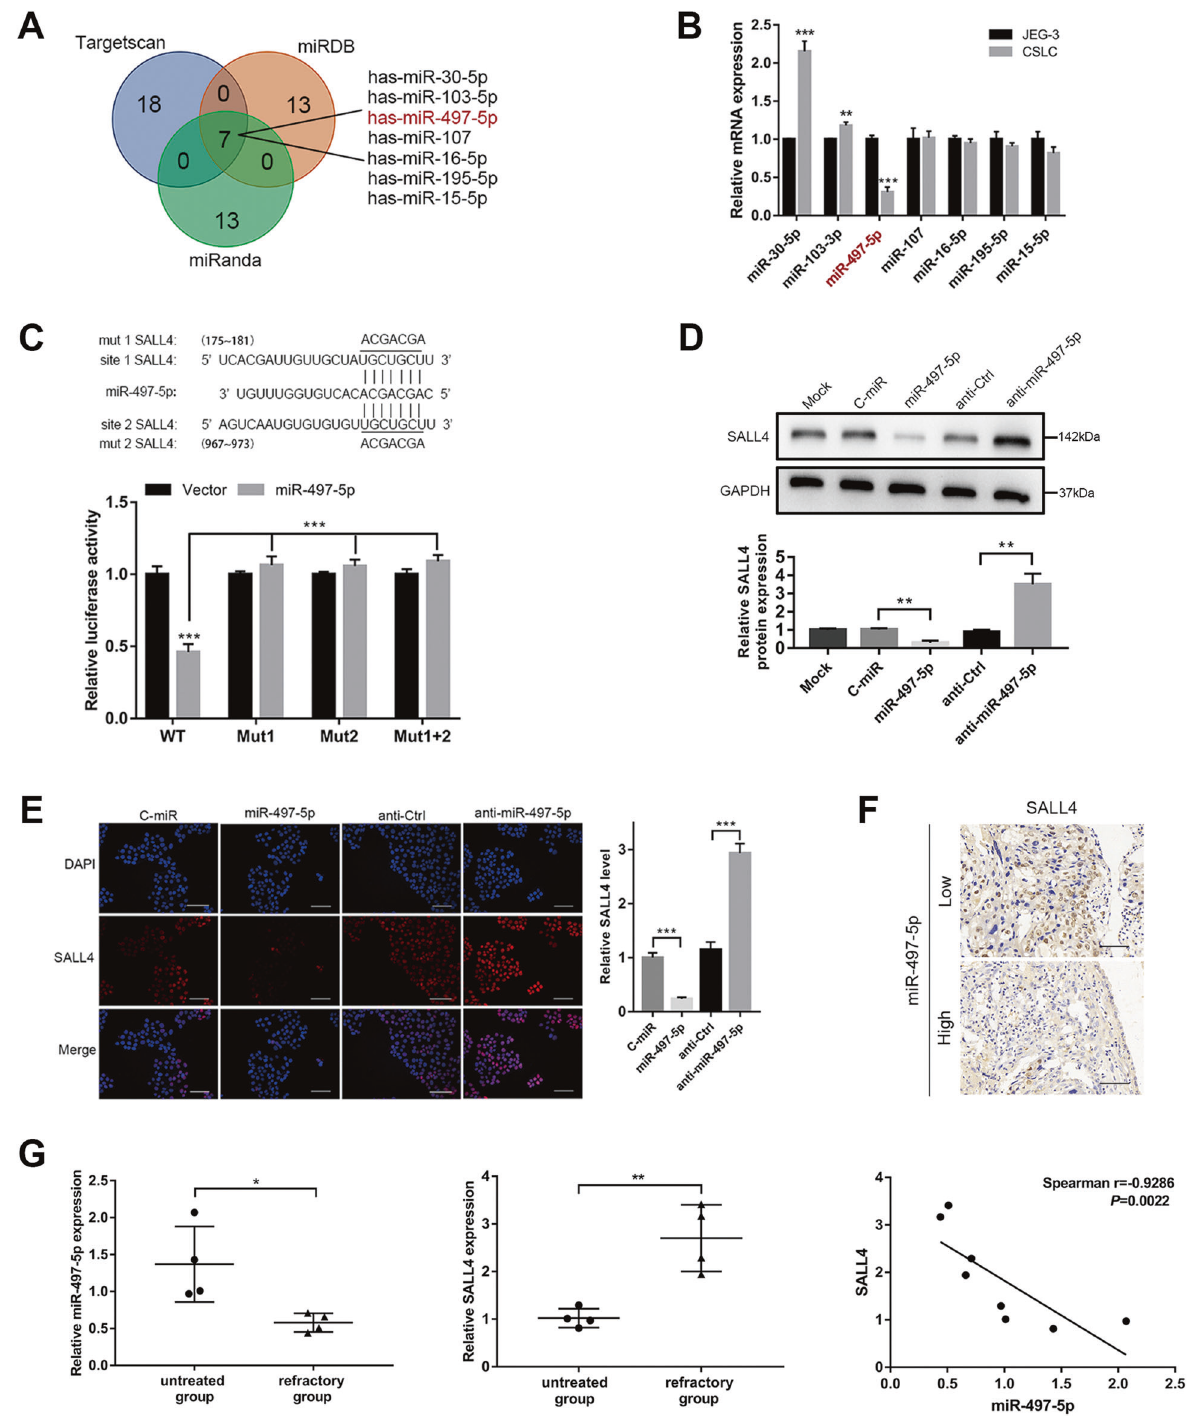
Fig. 3 miR-497-5p regulates SALL4 directly in choriocarcinoma CSLCs. A TargetScan, miRDB, and miRanda tools ’ analysis of miRNAs that potentially target SALL4. B qRT-PCR analysis of 7 miRNA levels between JEG-3 and CSLCs. C Schematic representation of SALL4 3 ′ UTR showed two putative miR-497-5p binding sites, including the wild-type and mutant (top); 293T cells were transfected with indicated expression plasmids. Luciferase activities were measured (bottom). D Western blot analysis of SALL4 protein levels (top) and quanti fi cation (bottom). E SALL4 localized in the nucleus by immuno fl uorescent analysis (left, magni fi cations: ×200) and quanti fi cation (right). F Representative images of SALL4 expression detected by IHC (magni fi cations: ×400). G qRT-PCR analysis showing that miR-497-5p inversely associated with SALL4 in choriocarcinoma tissues. Data represent mean ± SD from at least three independent experiments. ** P < 0.01, *** P < 0.001.